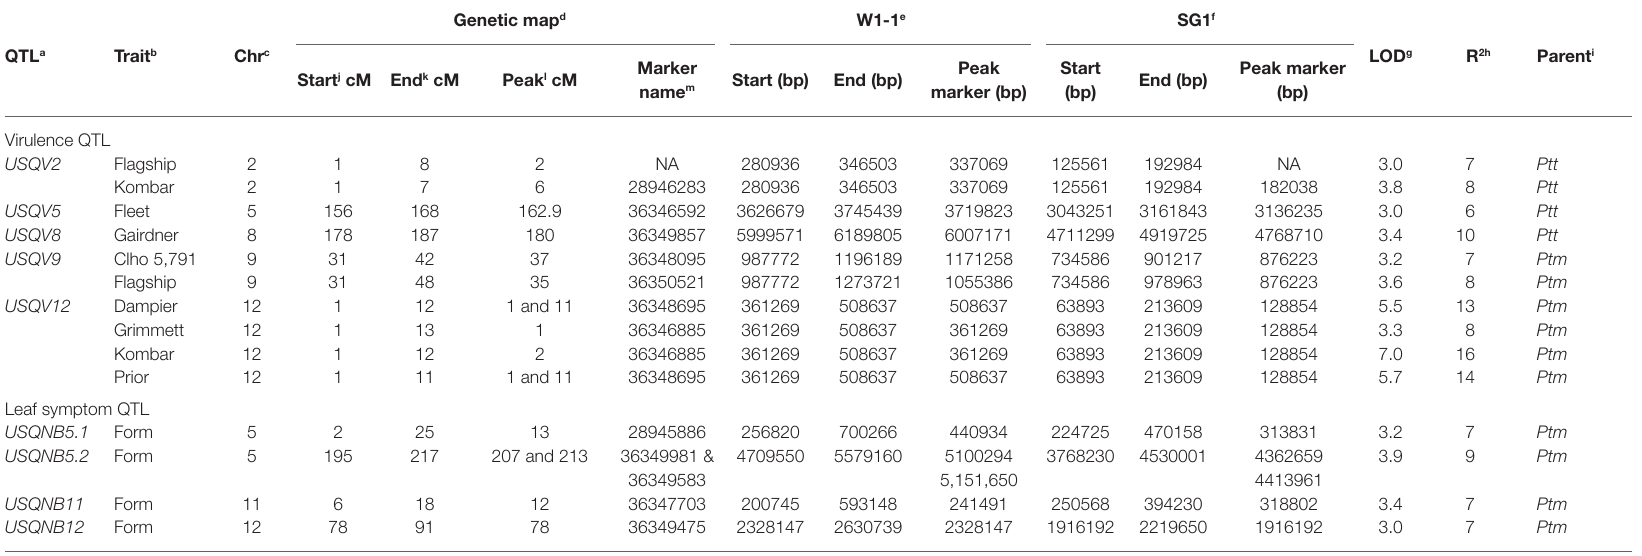
TABLE 3 | List of virulence and leaf symptom QTL identified using pop37 .